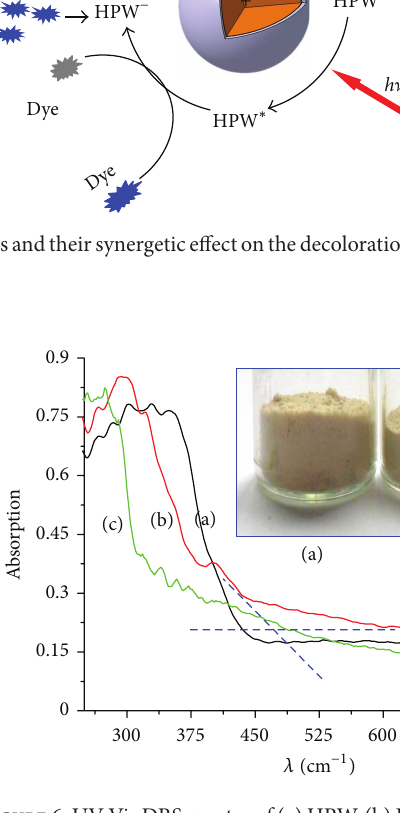
Figure 6: UV-Vis DRS spectra of (a) HPW, (b) HPW@yeast, and (c) pure yeast